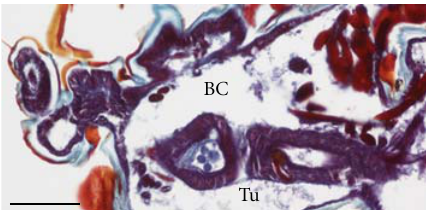
Figure 5: Detail of tubule (Tu) extending into the buccal cavity (BC) in the head of a N. abietis larva. (Same larva, di ff erent section as Figure 3.) Scale bar = 0.1mm.